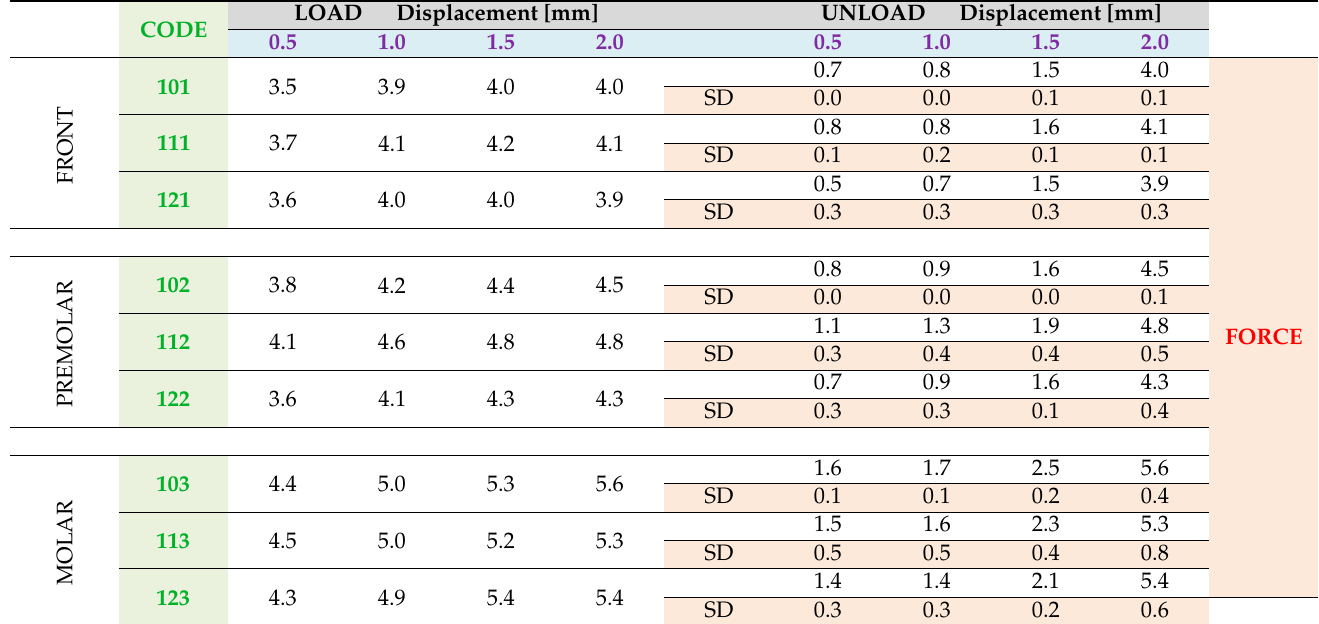
Table 2. Summarized average values of the released forces of TriTanium ®